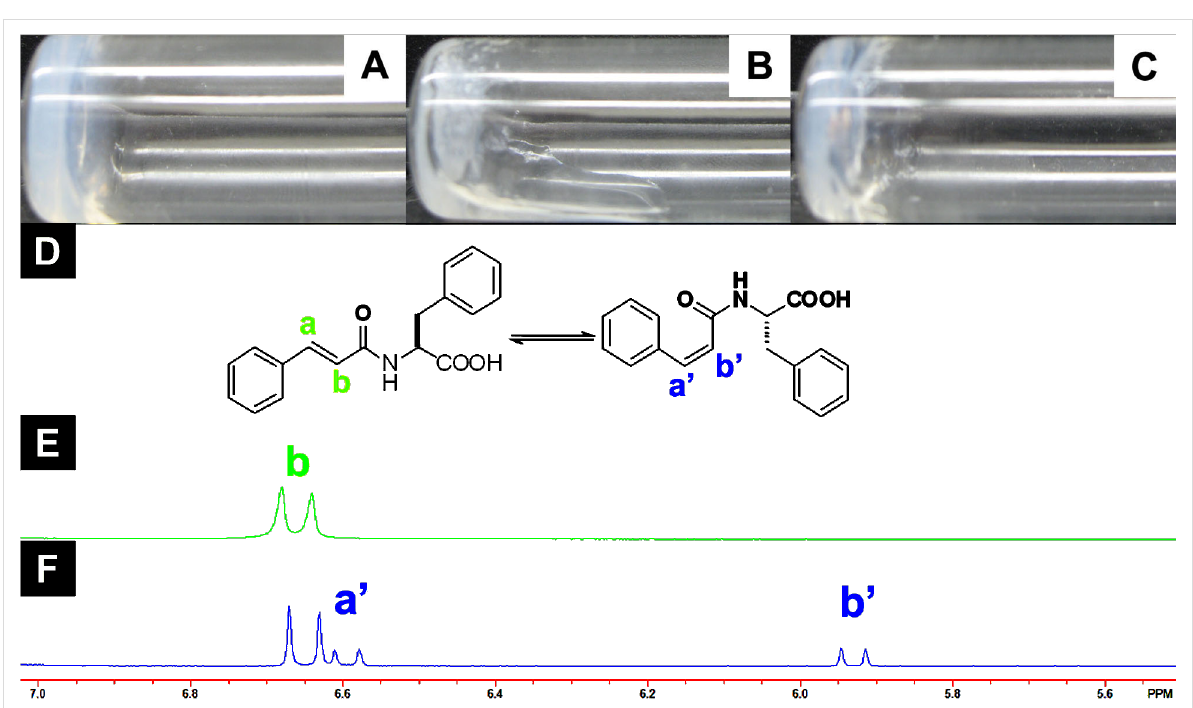
Figure 1: Optical images of (A) gel IV (1.5 wt %, pH = 4.6), (B) gel IV after UV irradiation (no aging), (C) gel IV after UV irradiation (aging 2 hours), (D) the structure of compound 6 in trans - and cis -isomers , (E) the NMR spectra of compound 6 before and (F) after UV irradiation for 2 hours.